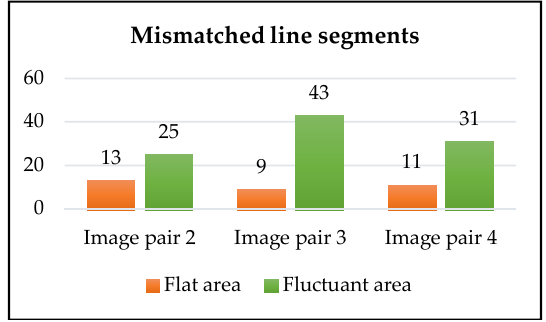
Figure 16. Comparison of the number of mismatched line segments between two different areas.